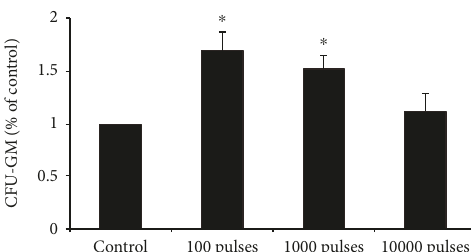
Figure 3: Changes of CFU-GM in mice after exposed to PEMF at di ff erent pulses. The clonogenicity was expressed as a percentage relative to the number of colonies counted in control dishes which was considered 100% of clonogenicity. All data were presented as mean ± SD . ∗ P < 0 05 vs. control.